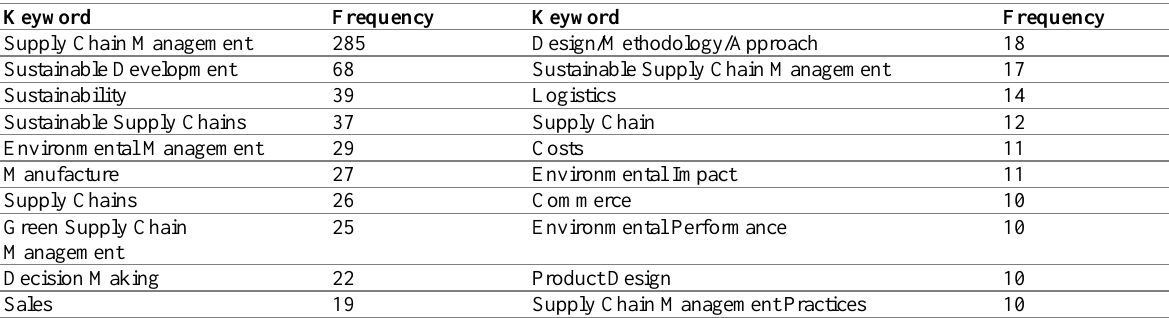
Figure 4 : Co-occurrence of Keywords; Source: Research data (2021) Table 10 : Most frequently used